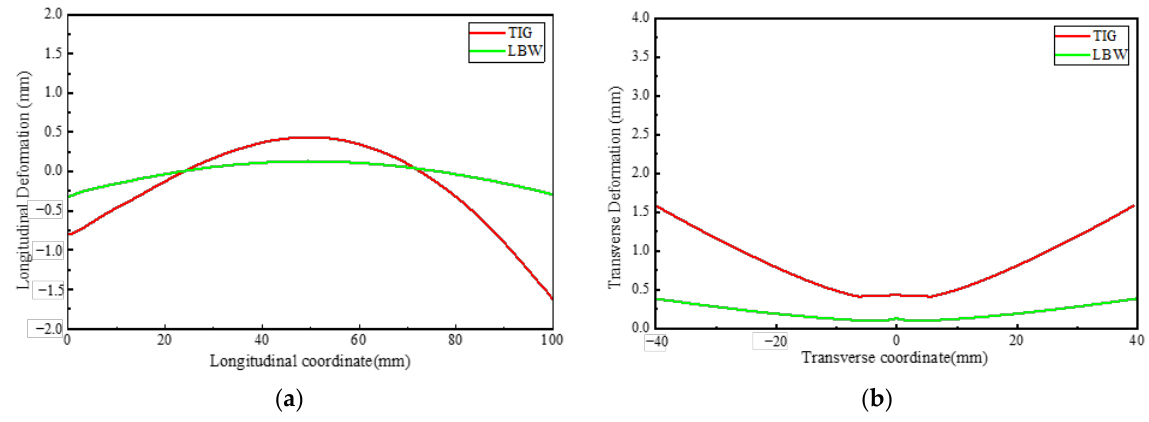
Figure 27. Experimental and simulation results of butt welding: ( a ) TIG weldment, ( b ) LBW weldment.